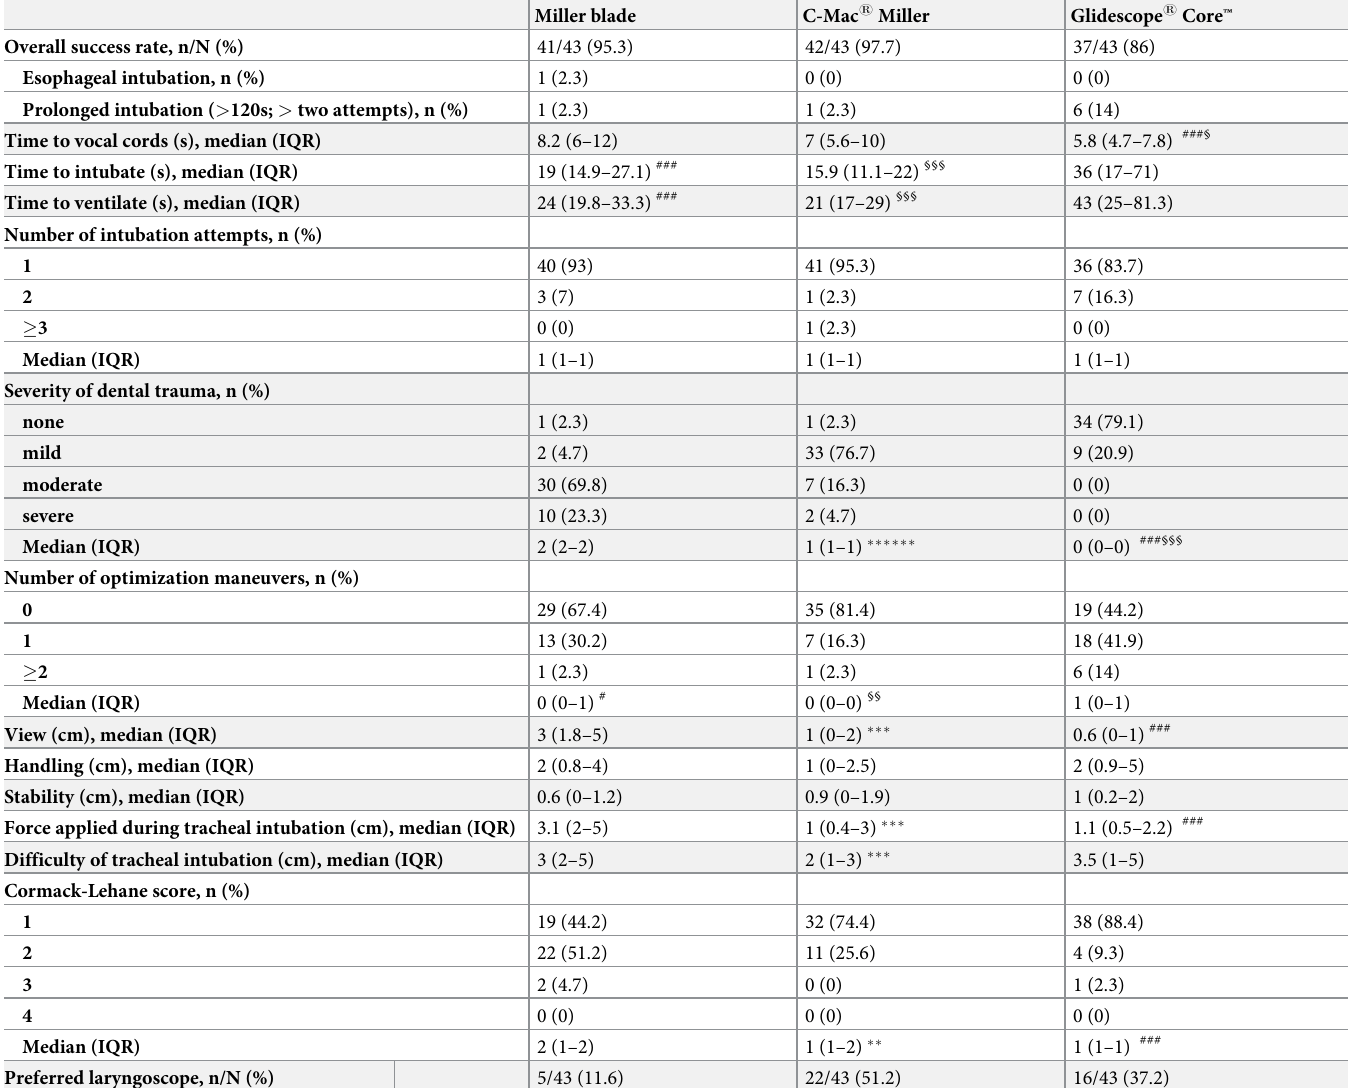
Table 3. Intubation data of the anesthetists with extensive previous